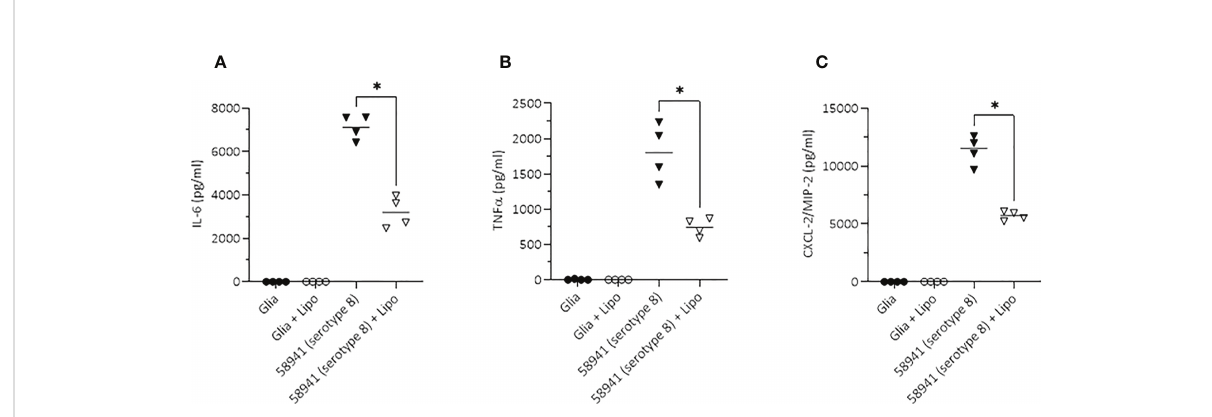
FIGURE 9 Inhibitory effect of liposomes on the neuroin fl ammatory response of mouse glial cells. Scavenging of the non-haemolytic pneumolysin of the serotype 8 strain 58941 by liposomes signi fi cantly reduced the pro-in fl ammatory response (determined by induction of the two major pro- in fl ammatory cytokines IL-6 and TNF a , and the chemokine CXCL-2/MIP2 corresponding to the human IL-8) in an in vitro meningitis model. Lytic release of PLY was achieved by treatment of the bacteria with penicillin during incubation with the glial cells. All values represent the mean, n = 4 independent experiments,